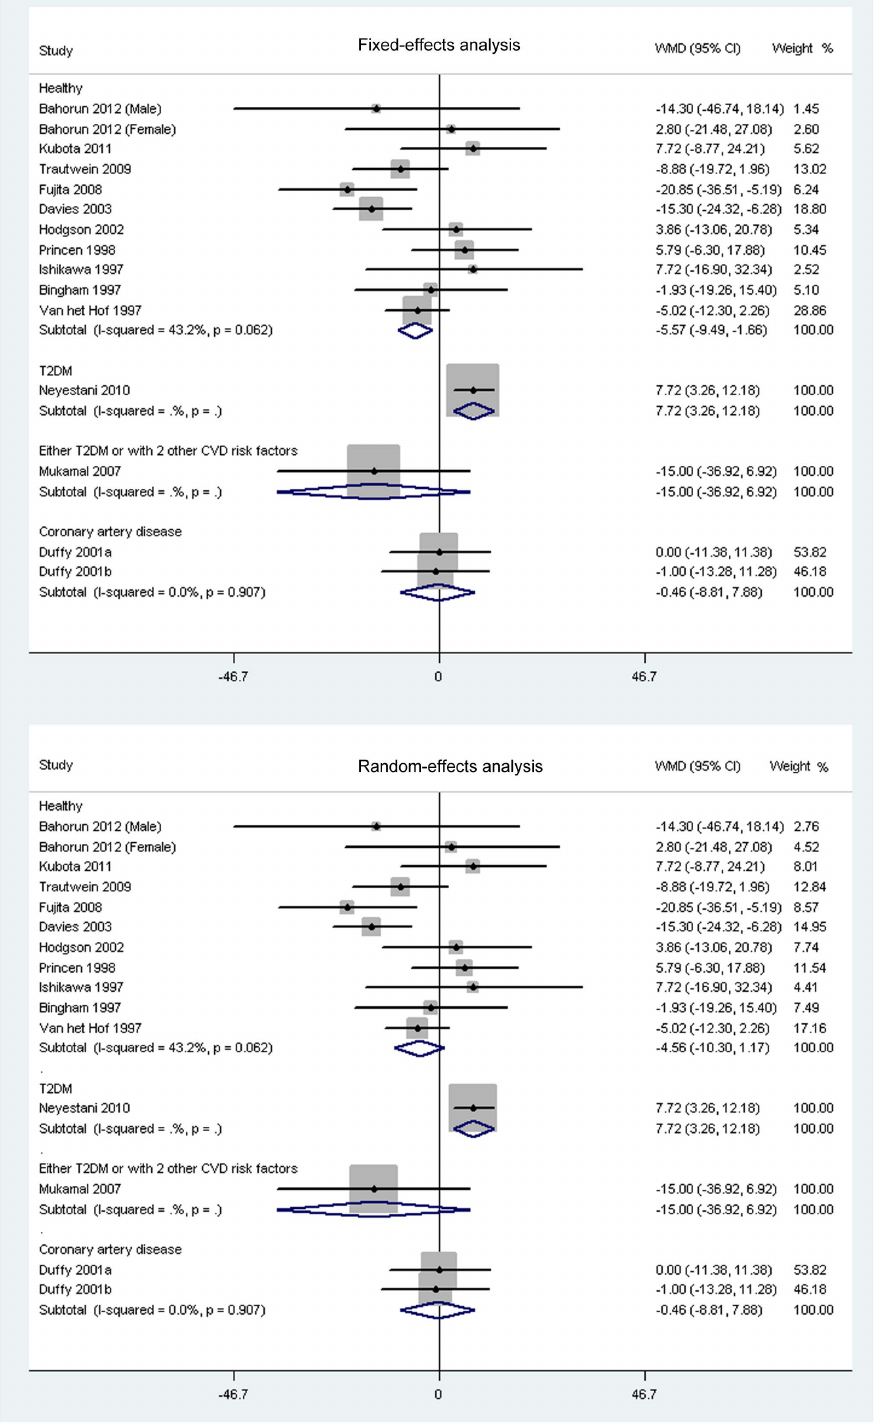
Figure 4. Meta-analysis of effects of black tea on concentrations of low-density lipoprotein-cholesterol (LDL-C). A meta-analysis was done with STATA software (Version 11; StataCorp, College Station, TX). Weight of each study was shown by sizes of data markers in the analysis. The diamond represents the overall estimated outcome and the results were calculated using a fixed-effects or random-effects model. WMD, weighted mean difference.